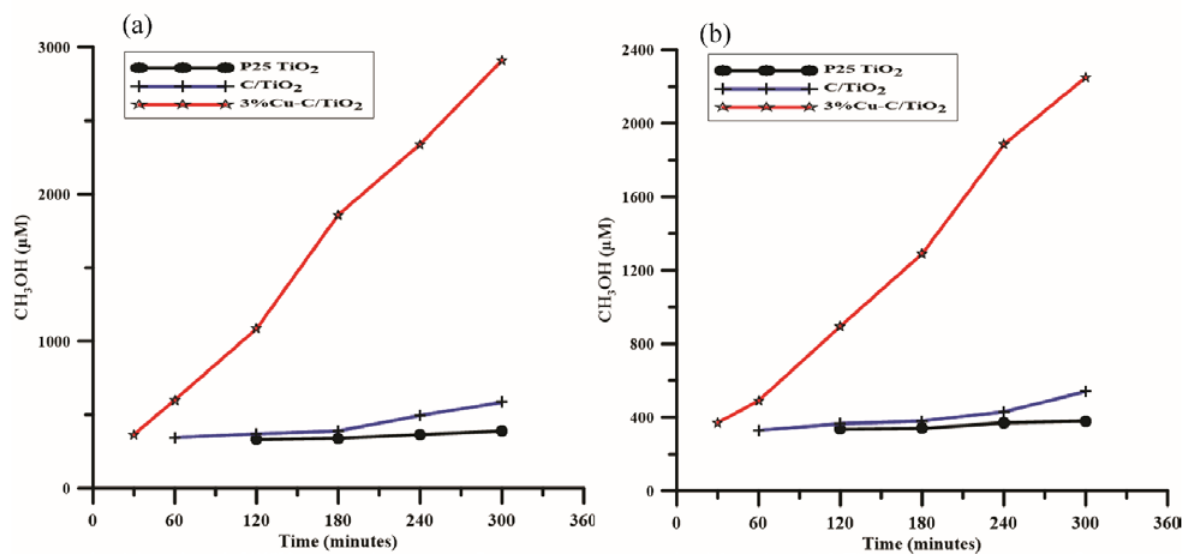
under UV light (a); PSW-1, (b); PSW-2.